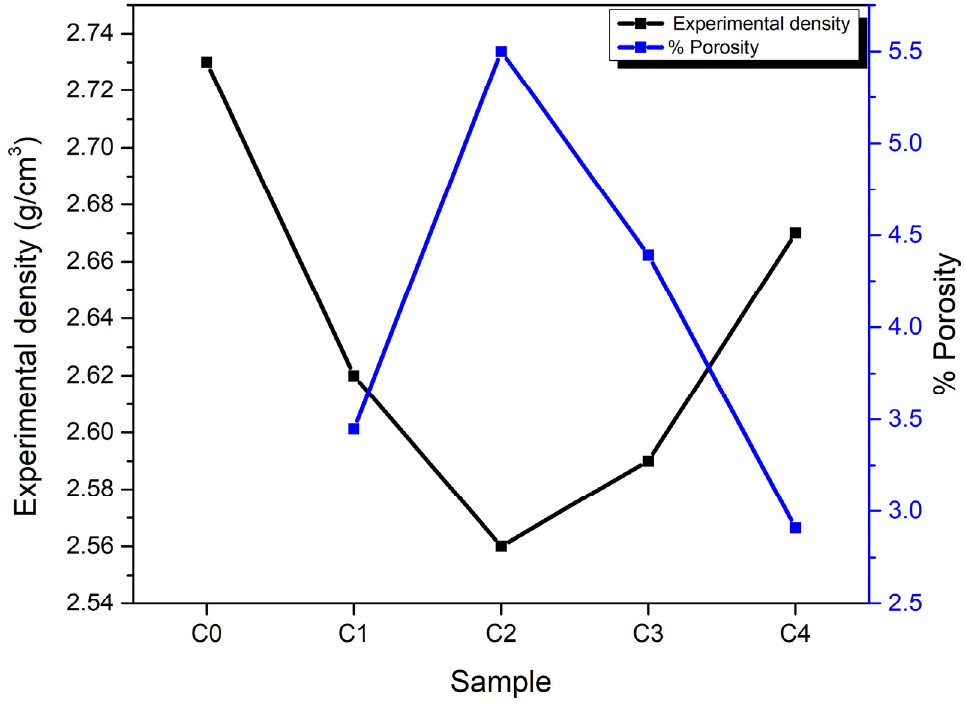
Figure 4. Experimental density and % porosity of the cast